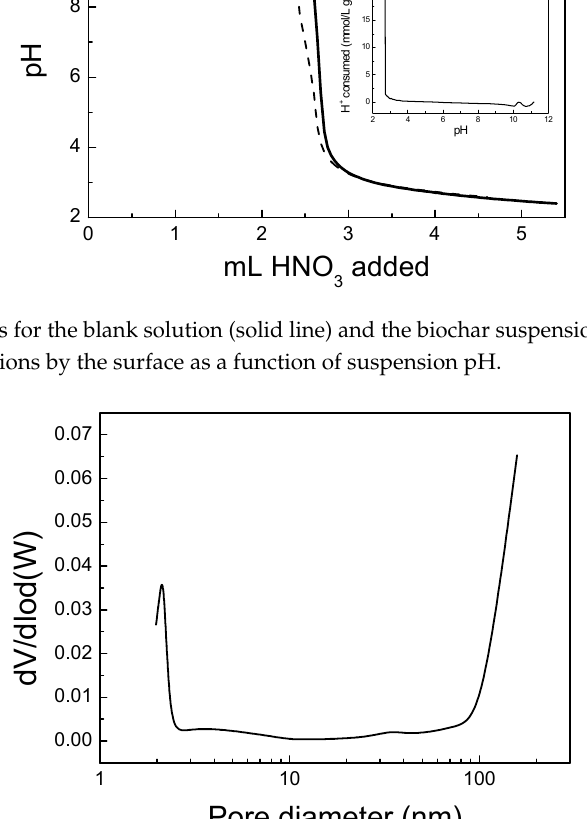
Figure 2. PMT curves for the blank solution (solid line) and the biochar suspension (dotted line). Inset: Figure 3. Pore size distribution of the Consumption of H + ions by the surface as a function of suspension pH. Figure 3. Pore size distribution of the biochar.